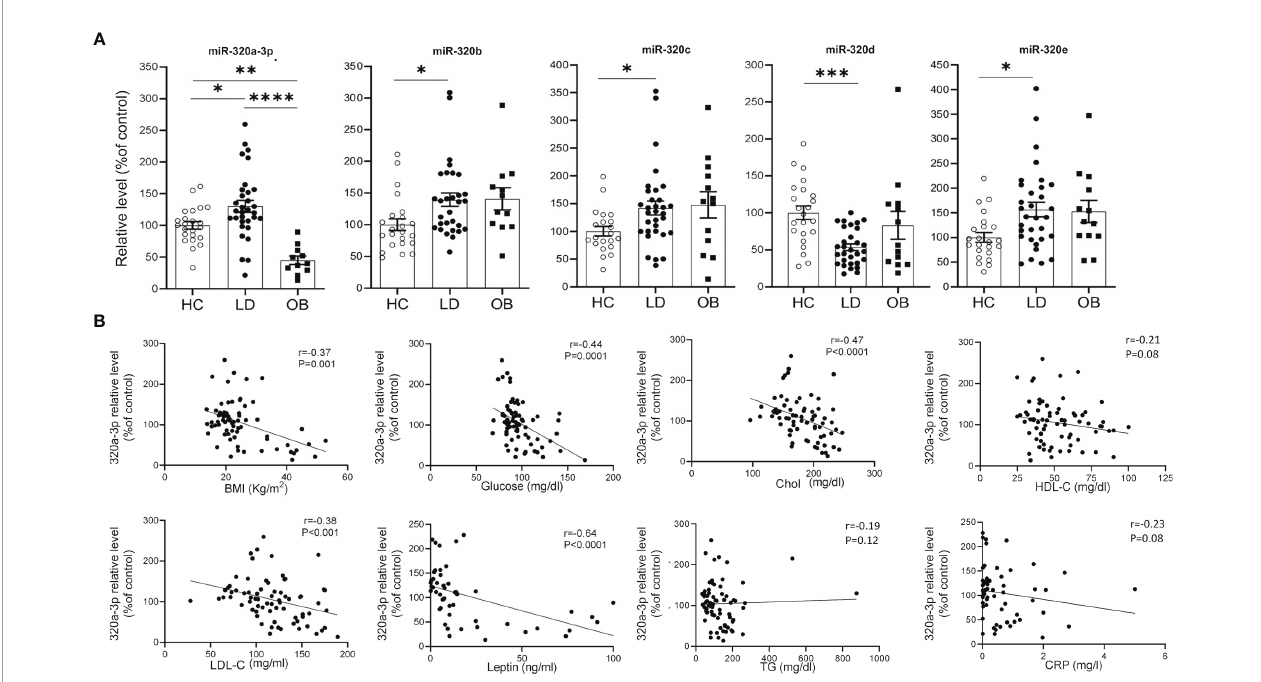
FIGURE 3 | Relationship between cmiRs-320s and metabolism. (A) Scatter plots with bar of circulating miRNAs from the 320 family in HC, LD and OB subjects. All data are expressed as percentage of the mean of HC and are shown as mean ± SEM. * P < 0.05, ** P < 0.01, *** P < 0.001 and **** P < 0.0001 by one-way ANOVA or Kruskal-Wallis, as appropriate. (B) Correlation analysis between BMI, glucose, total cholesterol, HDL-C, LDL-C, plasma leptin, triglycerides, CRP and cmiRs-320a- 3p in the total population (LD + OB + HC). Spearman ’ s r and relative p-value are indicated.